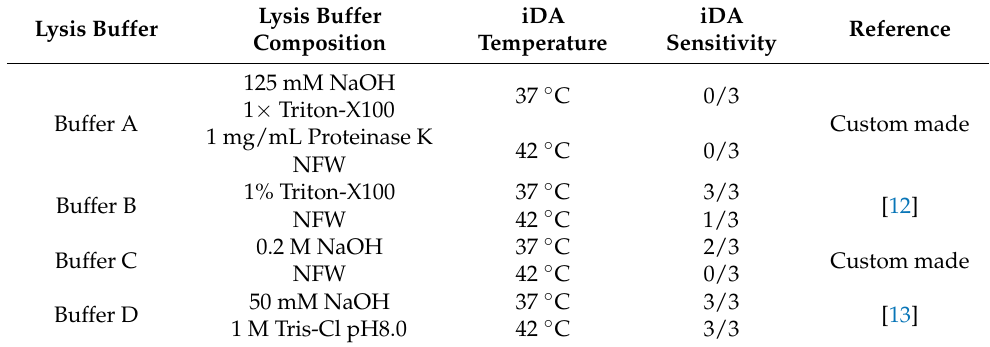
Table 1. A comparative analysis of different lysis buffers for